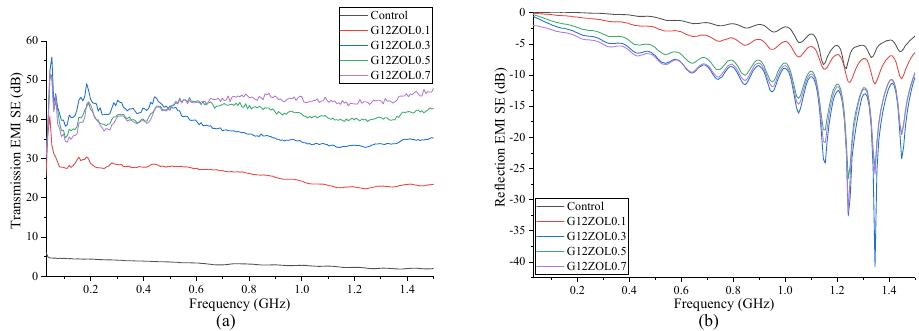
Figure 8. ( a ) Transmission EMI SE containing 12 mm CF; ( b ) reflection EMI SE containing 12 mm CF. 4. SEM Average EMI SE produced by the mixes with best shielding properties for the control mix and the mixes containing each CF type are 3.14 dB for the control mix, 29.58 dB for the mix with 0.7% of 3 mm CFs, 40.39 dB for the mix with 0.7% of 6 mm CFs, and 43.43 dB for the mix with 0.7% of 12 mm CFs.